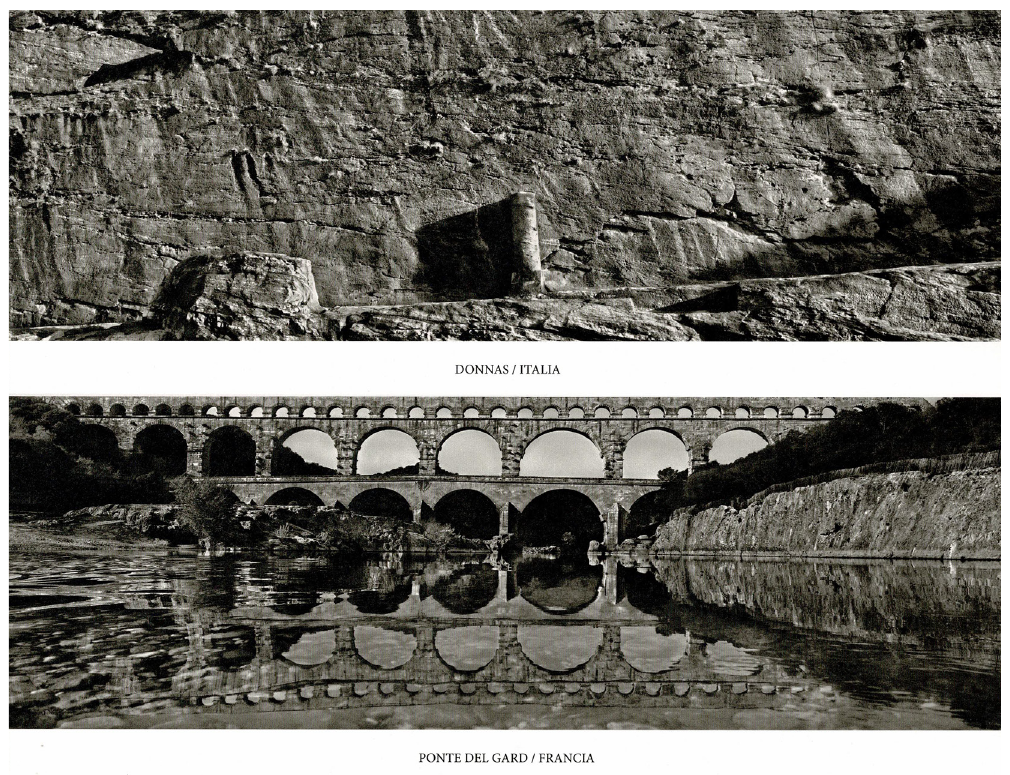
Fig. 3 Author, year, Donnas in Italy (above), Ponte del Gard in France (below). In Josef Koudelka,